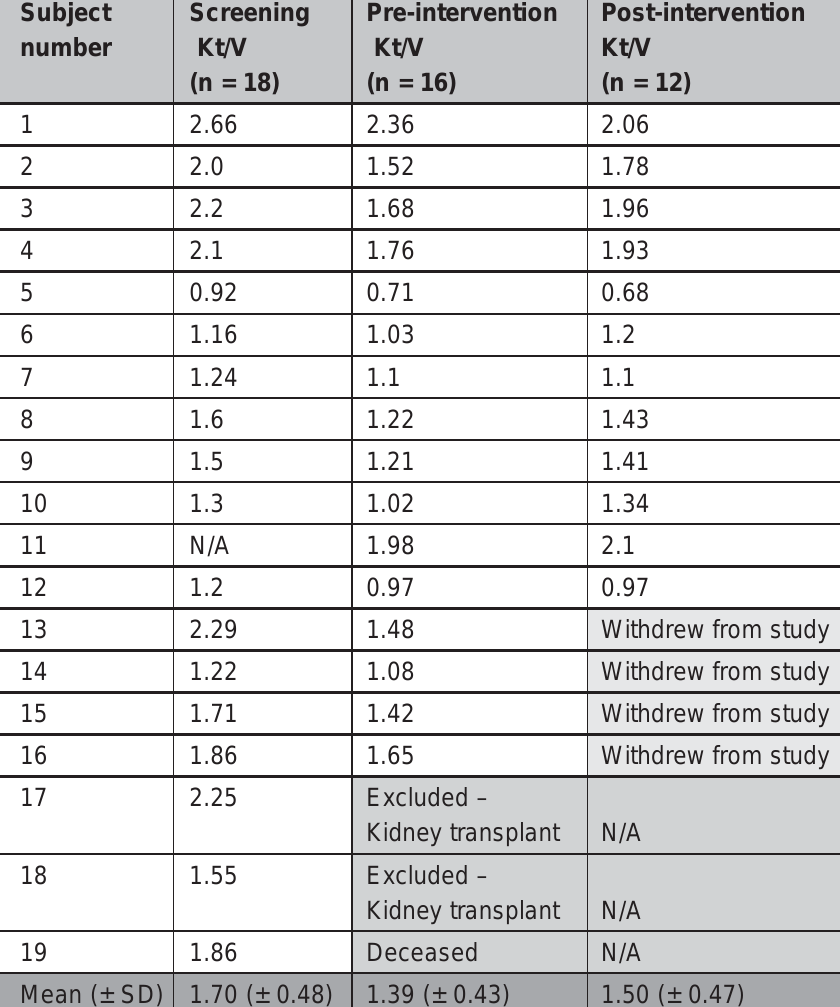
Table 2: Summary of dialysis efficacy (Kt/V) values.